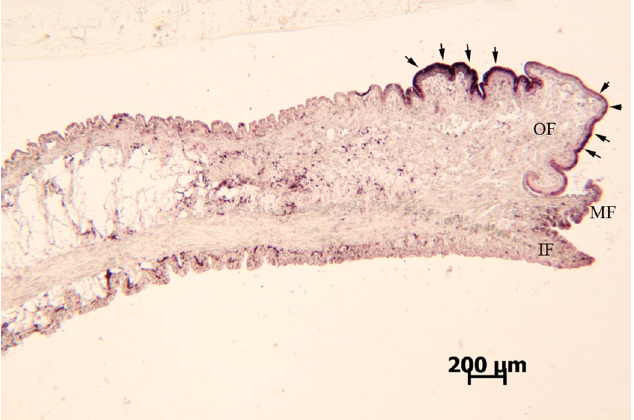
doi:10.1371/journal.pone.0135123.g006